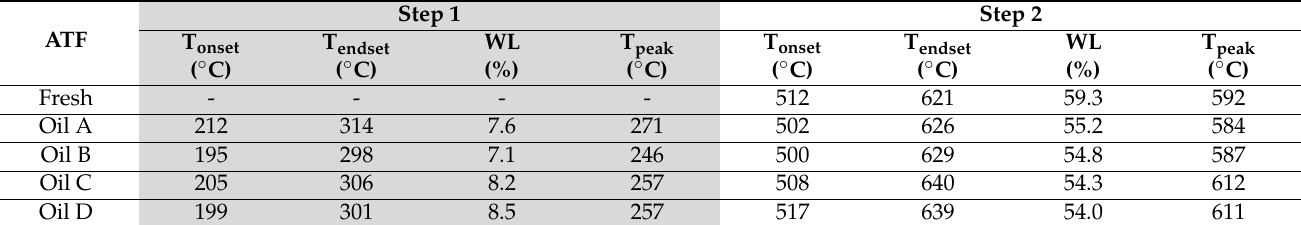
Table 9. TGA and DTGA data of fresh and 168 h aged